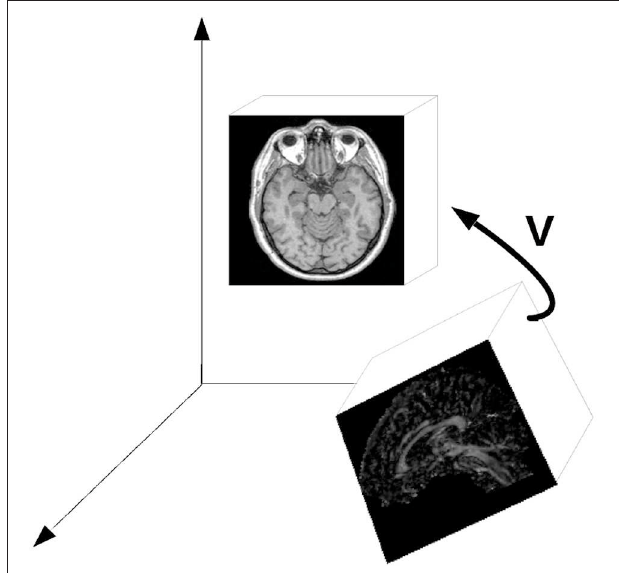
FIGURE 1 | The general principle of image registration; a spatial transform V—basically a combination of three-dimensional rotation and translation—is iteratively determined by comparing features in both image datasets (referred to as base and match images in the text). The important issue is the fact that the comparison of image element coordinates in a common frame of